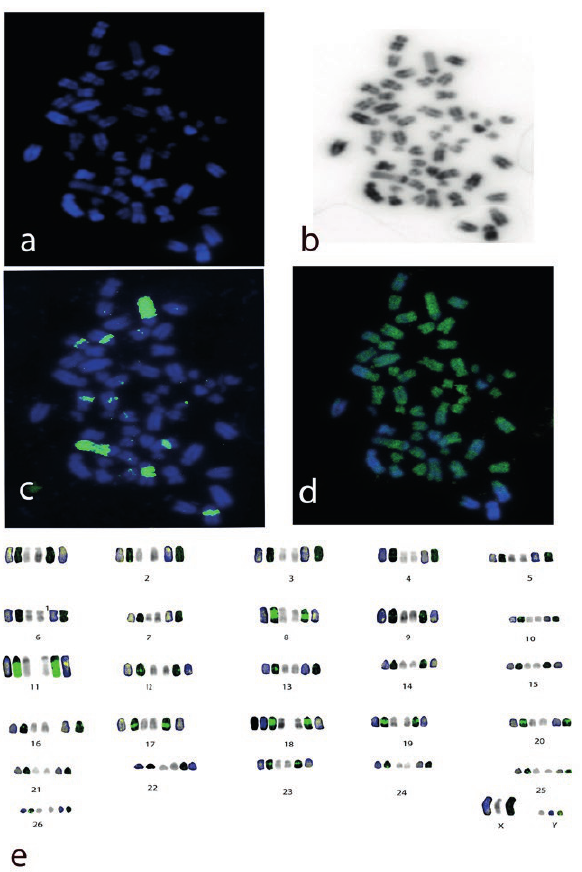
Figure 2. Metaphases of S. macrocephalus in DAPI (a), in DAPI inverted (b), Cap-A probe mapping (c), CMA3/DAPI stains (d), the reconstructed karyotype of S. macrocephalus from the metaphase in a) after sequential CMA3/ DAPI, DAPI inverted, FISH with Cap-A probes (e).